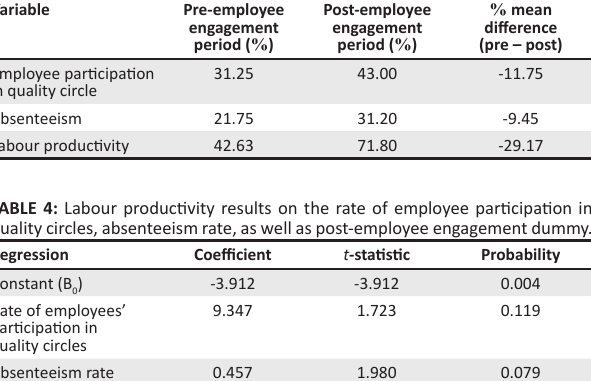
TABLE 3: Pre- and post-employee engagement percentage means comparison.